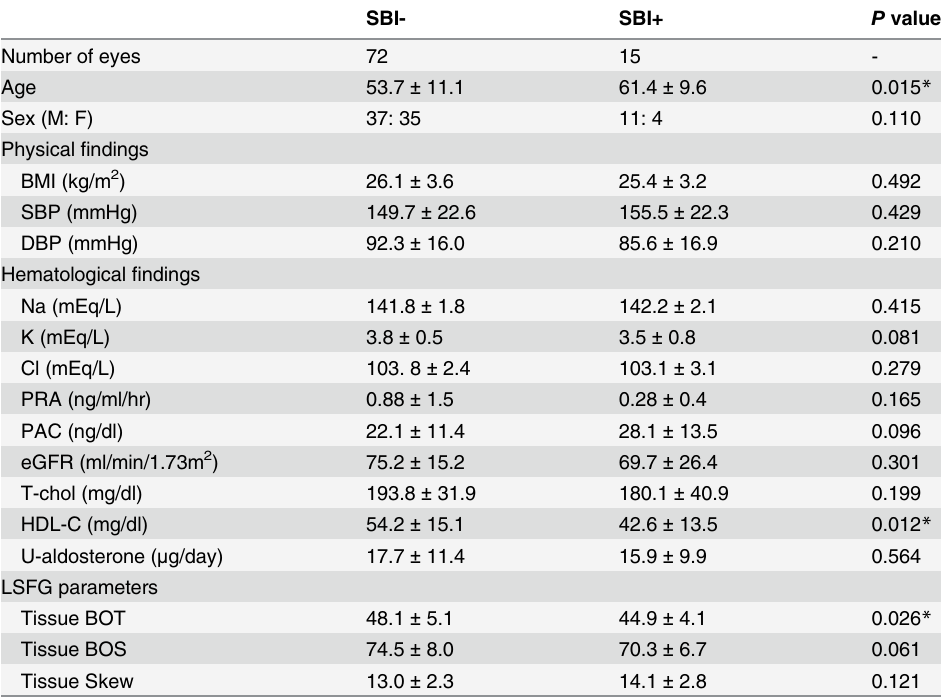
Table 1. Characteristics of eyes with primary aldosteronism with and without silent brain infarction. SBI- SBI+ P